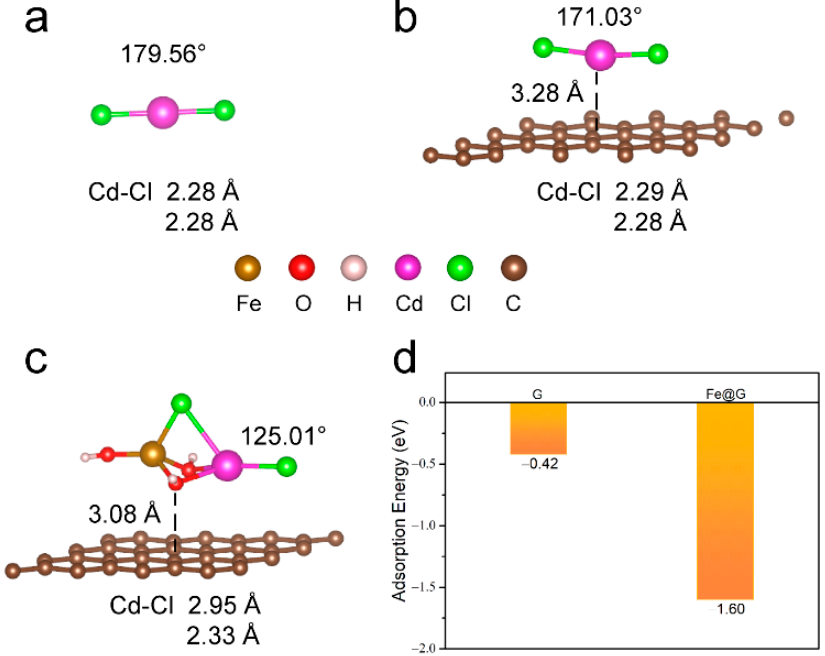
Figure 2. Schematic of pure CdCl 2 ( a ), CdCl 2 on G ( b ) and on Fe@G ( c ). ( d ) Adsorption energies of CdCl 2 on G and Fe@G.